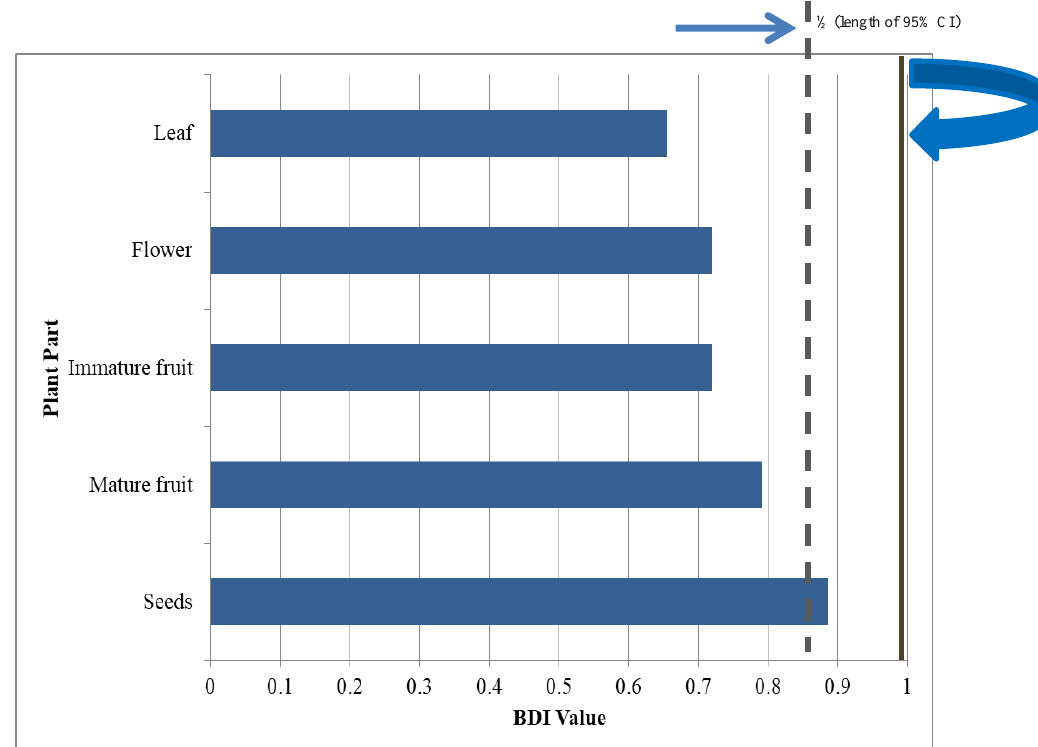
Figure 1. Mean BDI (± SEM) values of the essential oils from different parts of M. grandiflora against Ae. aegypti. All the essential oils were tested at 10 µg/cm 2 whereas DEET ( N , N -diethyl-3-methylbenzamide) was tested at 25 nmol/cm 2 and ethanol a solvent control. A BDI value greater than 0 indicates biting deterrence relative to ethanol and a BDI value not significantly different from 1 shows deterrence similar to DEET.